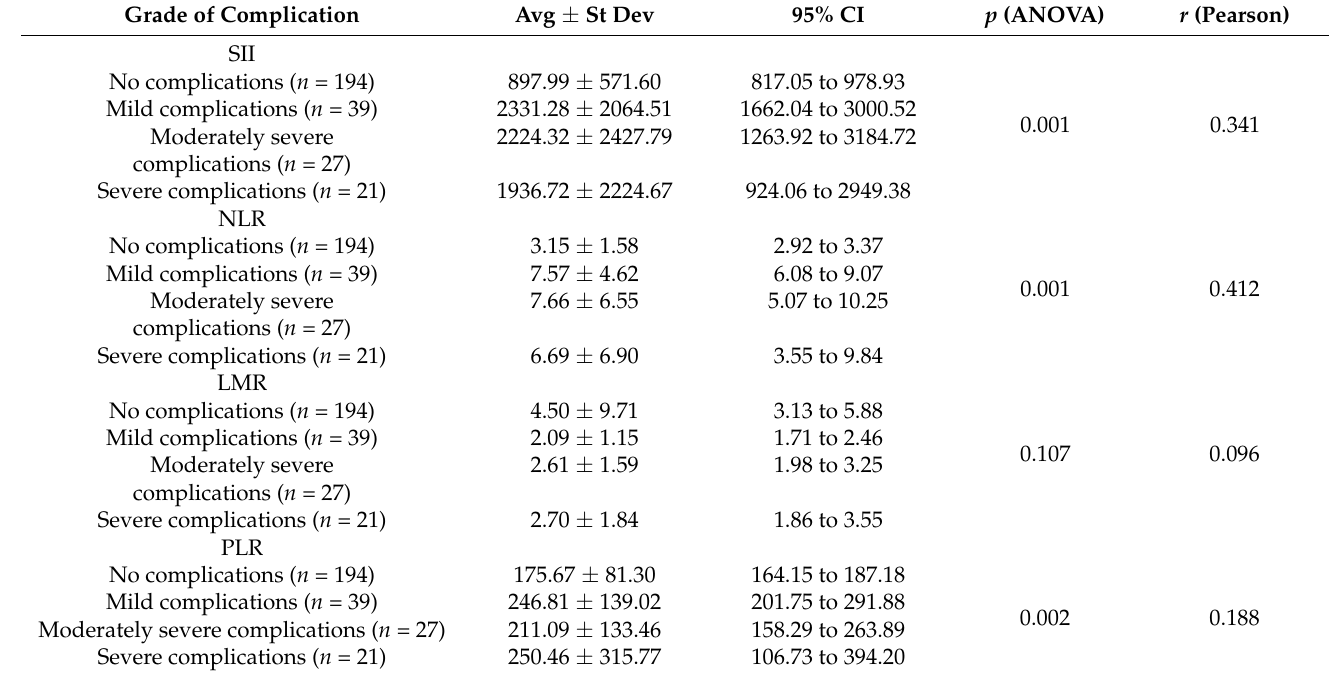
Table 4. Variation in preoperative immunocyte-derived markers in relation to postoperative